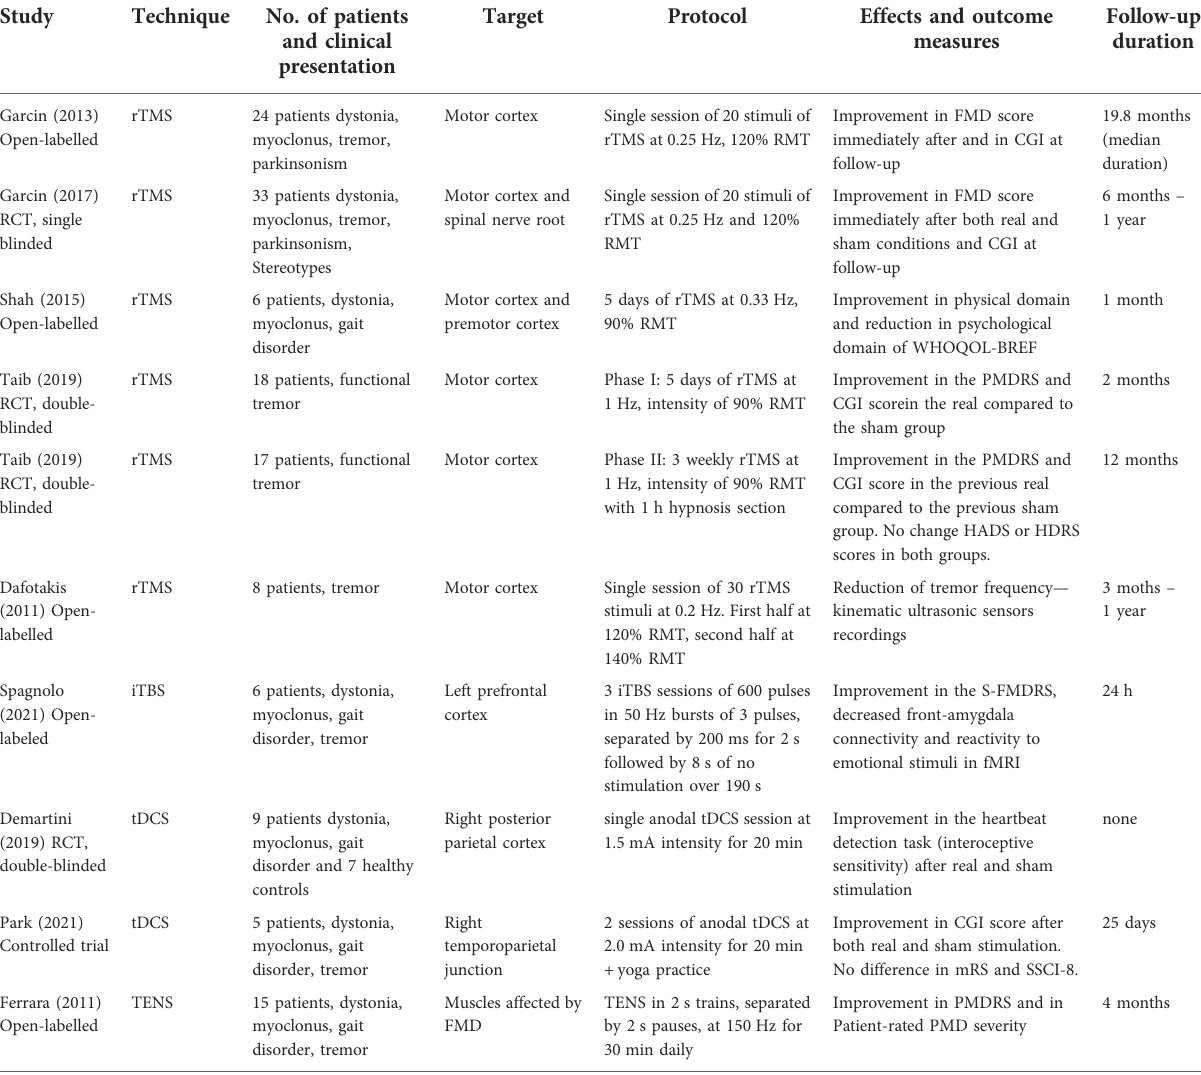
TABLE 1 Summary of the neuromodulation studies in